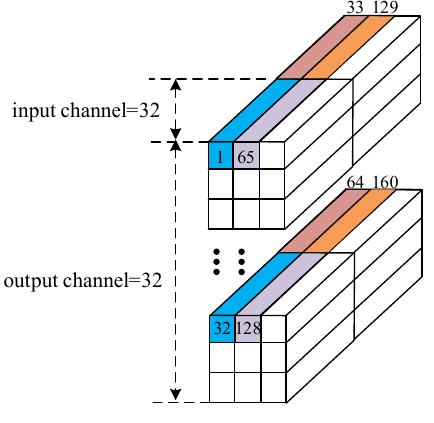
Figure 7. Weight data partitioning.